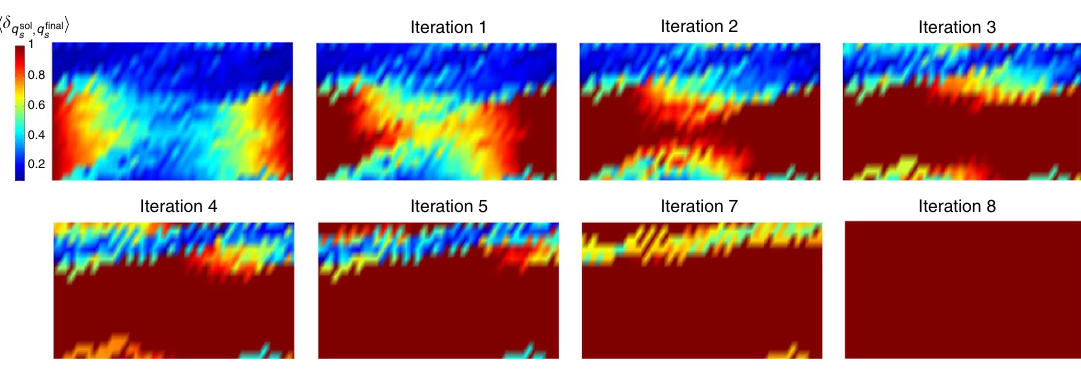
Figure 8 | Growing correlation length with learning for mixed boundary conditions. Annealing with learning for mixed boundary conditions and systems of size 16 (cid:4) 42 with 20% TOFFOLI gates. The annealing time within each iteration is t a ¼ 2 13 , and the probability threshold a ¼ 0.7. After iteration 6 (not shown), the correlations fully build up along the longitudinal direction, t a is then increased to t b ¼ 2 18